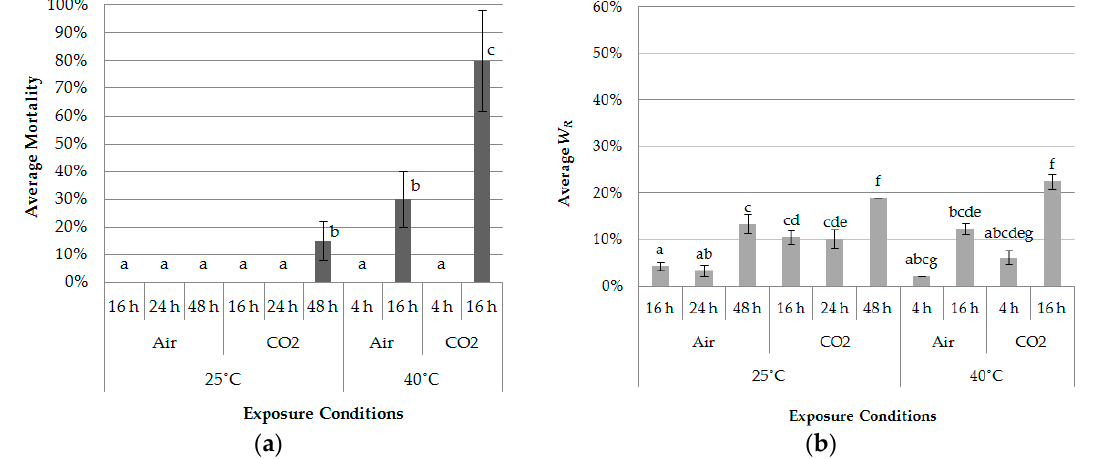
Figure 5. Average mortality and W R of larvae of L. africanus after the low vacuum treatment at 20–25 °C and 45% ± 5% relative humidity (RH) with air purge and CO 2 purge ( n = 5): ( a ) Average mortality (mean ± SD) after low vacuum treatments (40 kPa) and purging; ( b ) Average W R (mean ± SD) after the low vacuum treatments (40 kPa) and purging. For each condition, means followed by the same